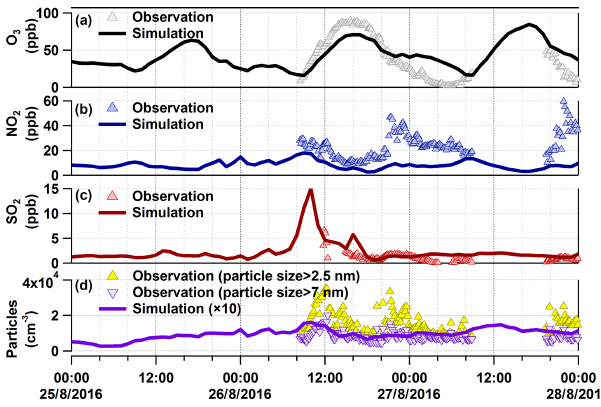
Figure 4. Comparison between observations and model results for O 3 , NO 2 , SO 2 , and particle number in the organic-rich episode. The modelled particles do not represent the ultrafine particles to their full extent, especially for the particles in the nucleation